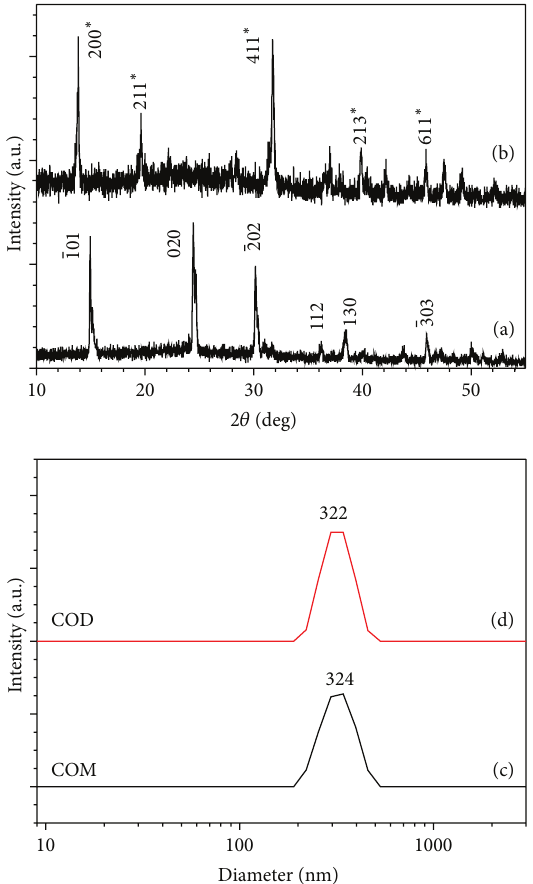
Figure 1: XRD patterns (a, b) and size distribution of submicron CaOxa (c, d). (a, c) COM; (b, d) COD.